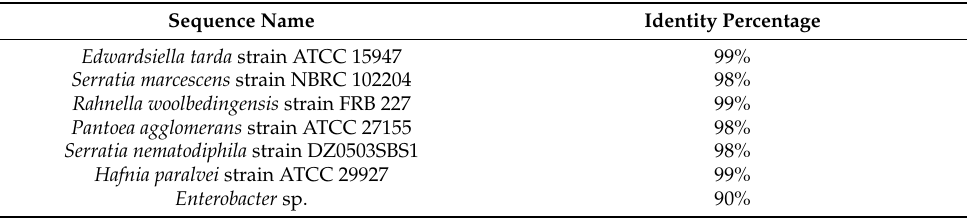
Table 1. List of endogenous probiotic candidates isolated from the entire honeybee gut. Identity percentage (quantitative measure of two sequences’ similarity, indicating degree of relatedness) was identified with the BLAST database “rRNA_typestrains/prokaryotic_16S_ribosomal_RNA” from